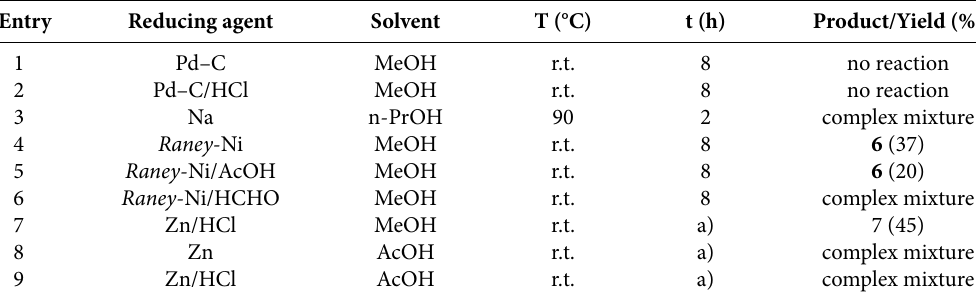
Table 1. Reduction of oxime 4 under various reaction